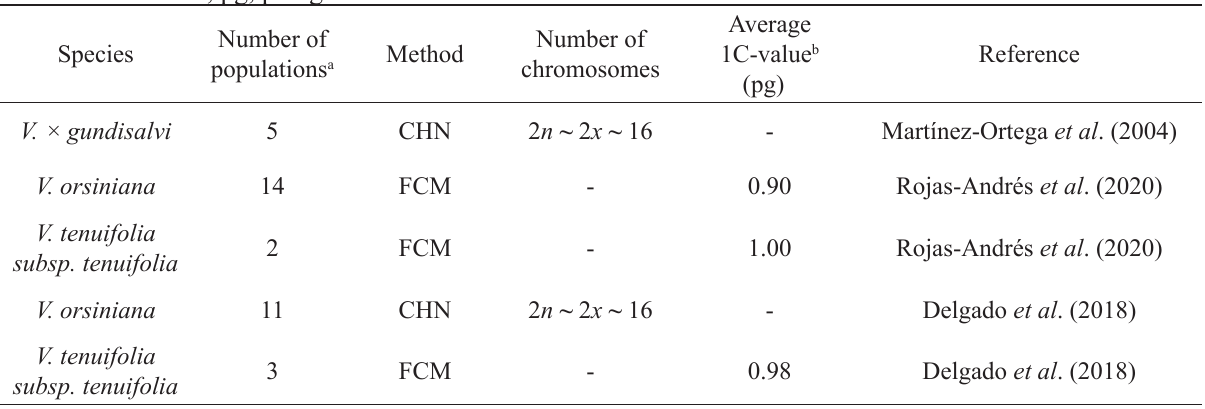
Table 2. S ummary of the previous information available on ploidy level estimations and chromosome counts of V. × gundisalvi, V. orsiniana and V. tenuifolia subsp. tenuifolia . a, t hree to five individuals per population were included in the analyses; b, o nly values that did not exceed the 5% threshold were considered; pg, picograms